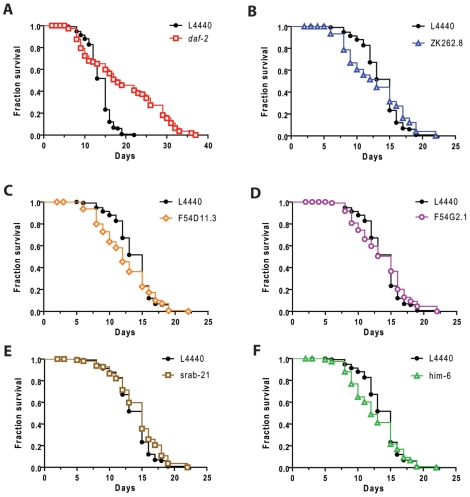
No effects on lifespan by die gene RNAi knockdown.Lifespan survival curves for animals grown on L4440 empty vector bacteria versus RNAi bacteria. (A) The effect of daf-2 RNAi on lifespan is shown as a positive control and is significantly different from L4440 lifespan – p≪0.01 Mantel-Cox Log-rank test. (B-F) None of the other RNAis significantly lengthen lifespan at the p<0.01 level. Lifespan assays were performed with 120 animals/RNAi grown at 20°C.